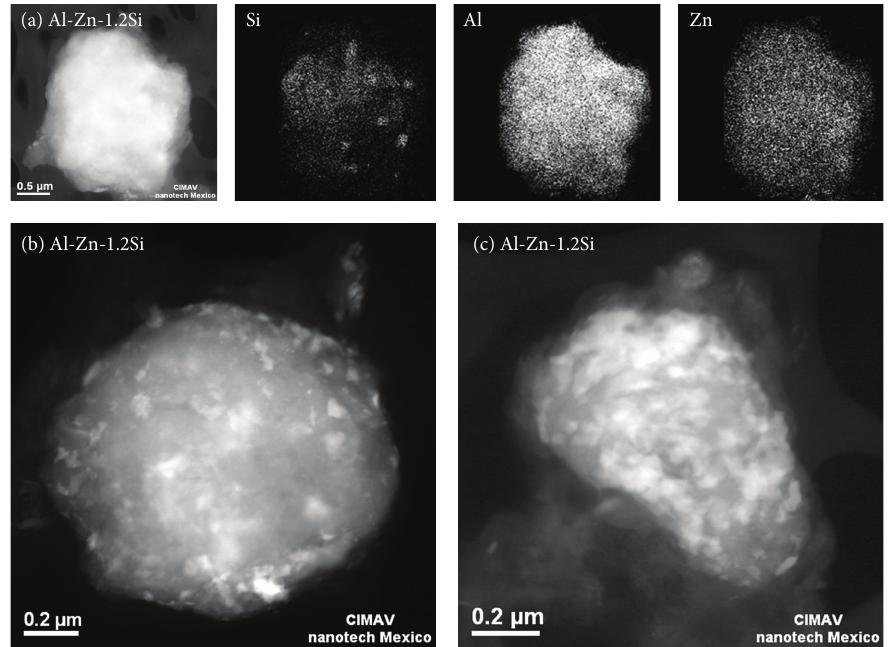
Figure 2: (a) Elemental distribution maps of Al-Zn-1.2Si (wt%) nanocomposite; ((b) and (c)) dark field Z-contrast images obtained from STEM of Al-Zn-Si